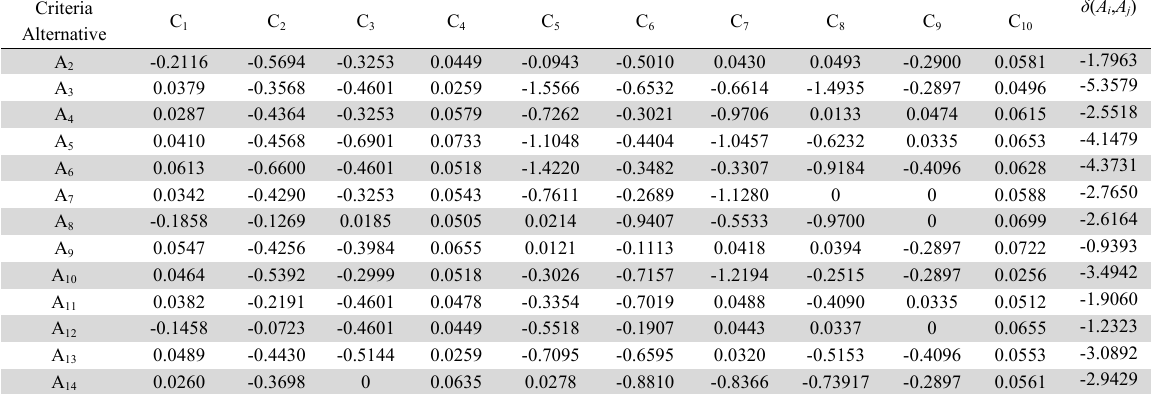
Partial dominance degrees of housing project A 1 over others with respect to each criterion Criteria Alternative